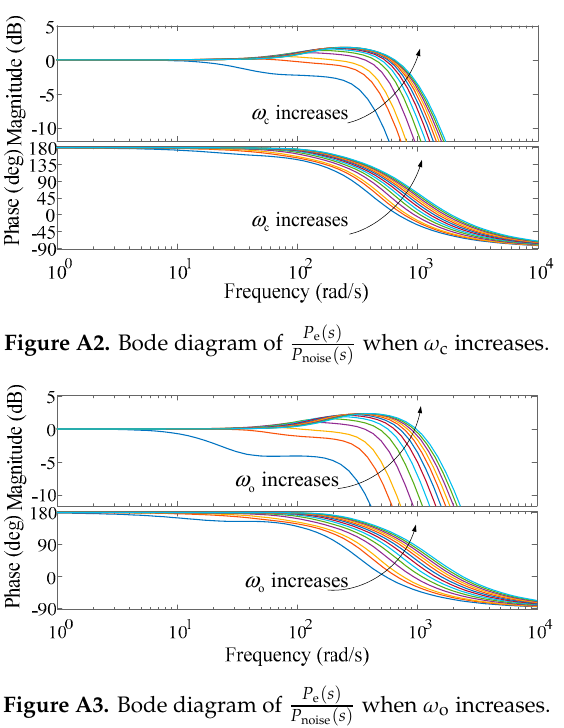
Figure A3. Bode diagram of P e